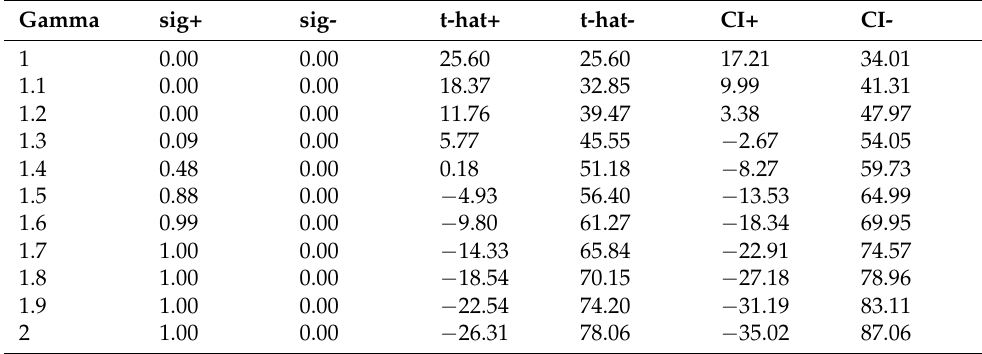
Table 10. Sensitivity-analysis table for propensity-score matching (using fifth graders as an example). Figure 3. The coincidence of the sample propensity values of the post-matching treatment and control groups. Gamma